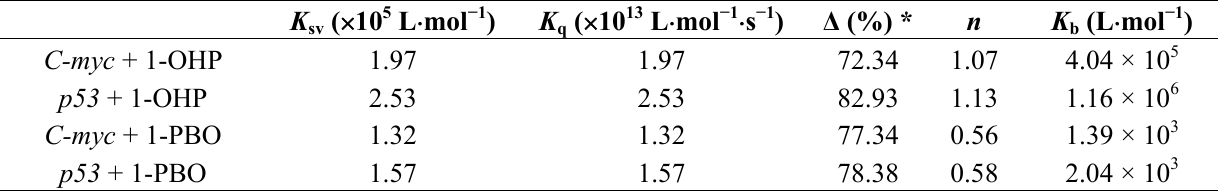
Table 1. Summary of pyrene derivatives—DNA interactions observed by fluorescence spectroscopy.